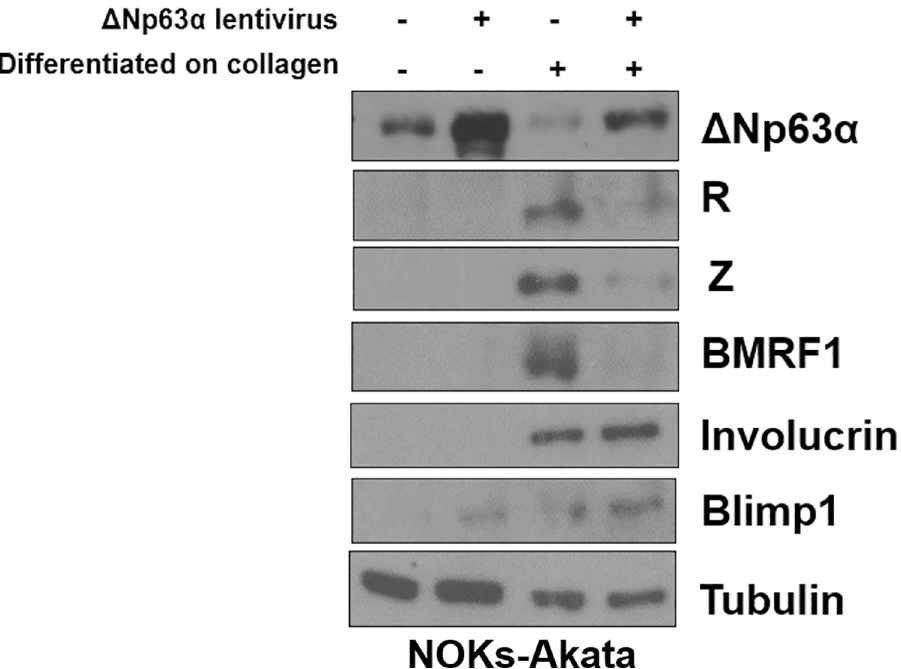
Z, BMRF1, Δ Np63 α , involucrin, BLIMP1, and tubulin proteins was determined as